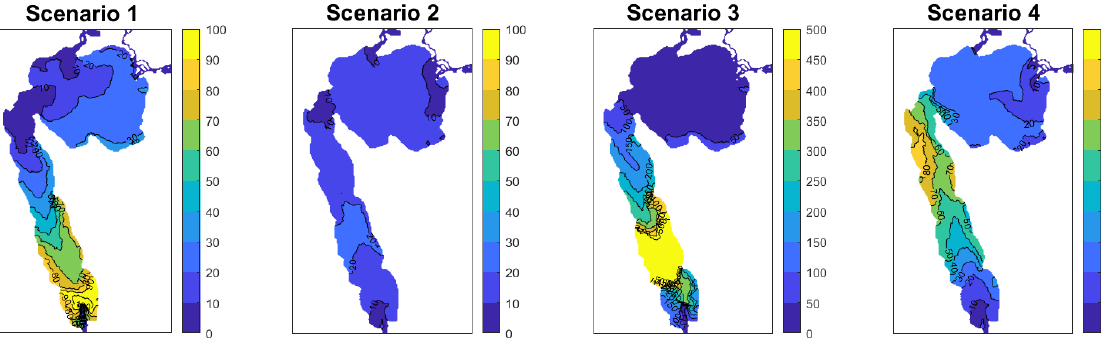
Figure 7. Spatial distribution of modelled WRT in four selected